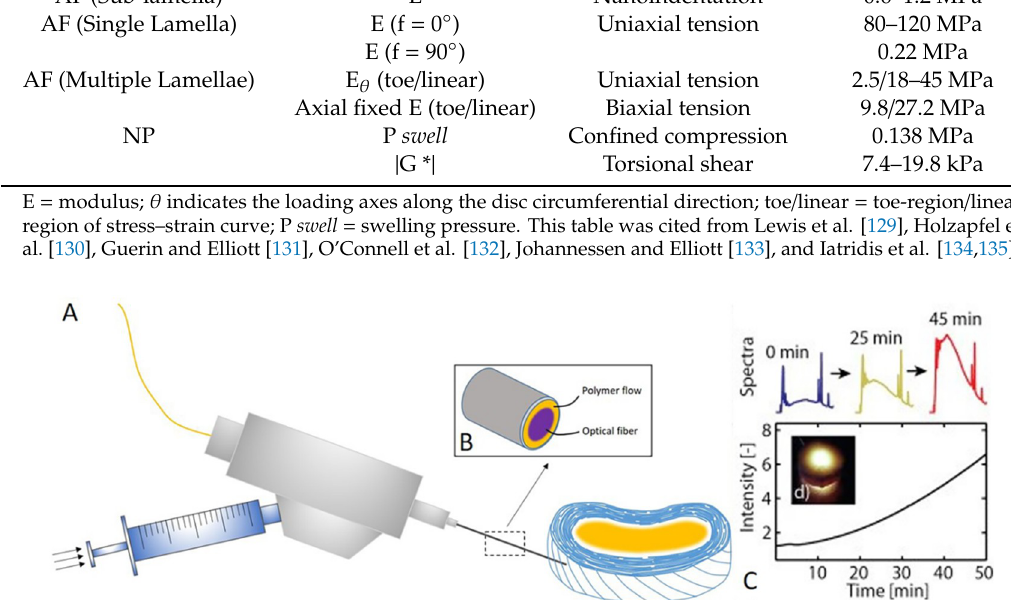
Figure 3. ( A ) Customized minimally invasive surgical probe used for hydrogel implantation. Liquid hydrogel precursor injection and illumination are performed by a single needle cannula.